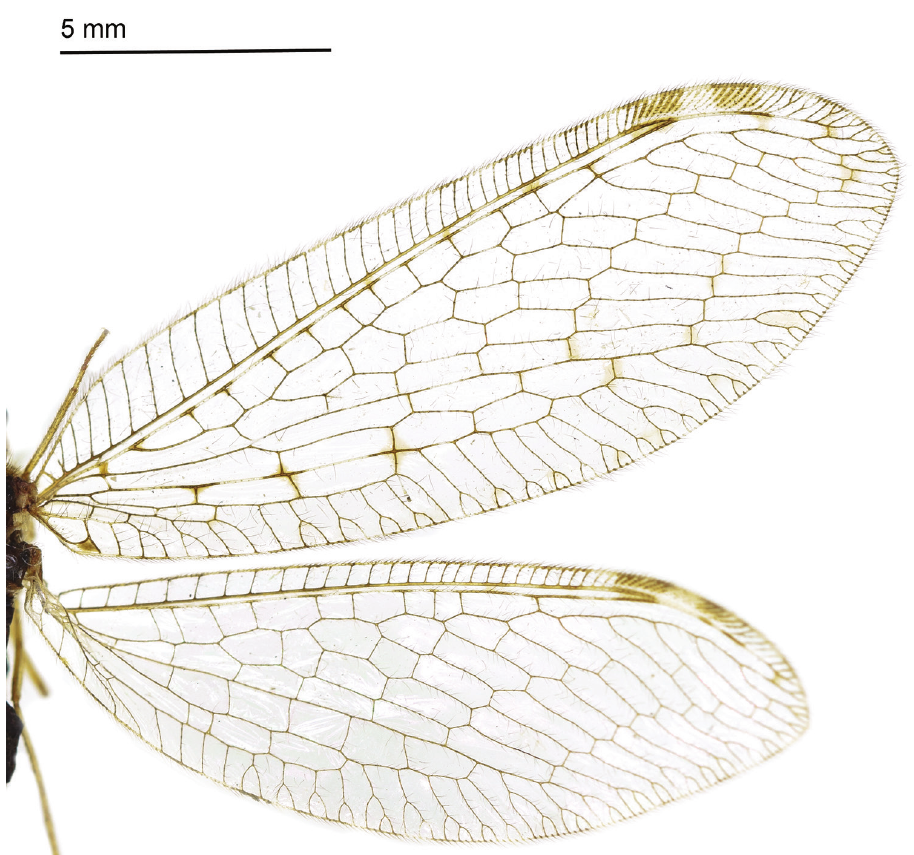
Figure 21. Wings of Heterosmylus wolonganus Yang, 1992.